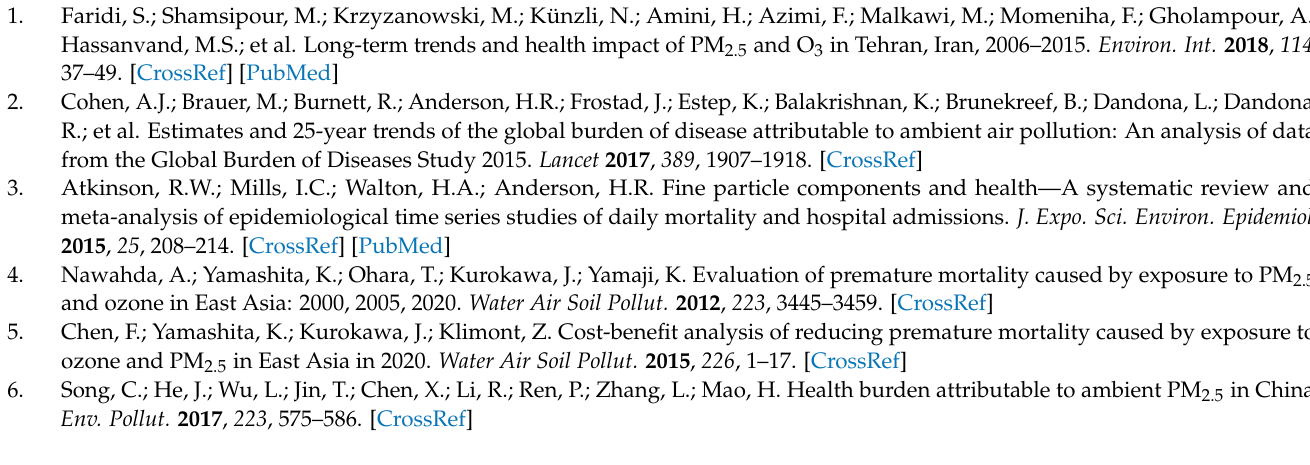
Table S1. Population (10 4 ) and Death rate (‰) at Beijing City, Tianjin City, and Hebei Province; Table S2. Data sources of PM2.5 compositions (particulate OC, EC, SO 42 − and NO 3 − ) at Beijing since 2013 to 2020; Table S3. Estimates for extra risk values (ER) and 95% confidence intervals (95% CI) of all-cause mortality attribute to PM 2.5 and